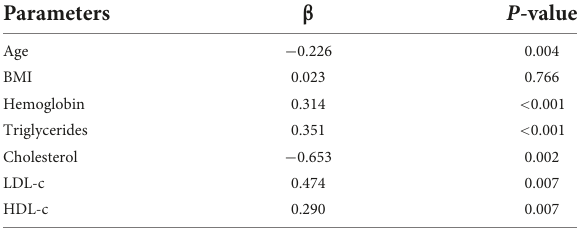
TABLE 3 Multiple linear regression analysis of the correlation between PNI and clinicopathological